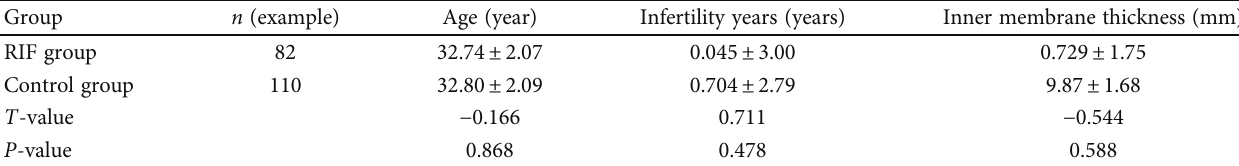
Table 1: Comparison of basic information between the two patient groups.